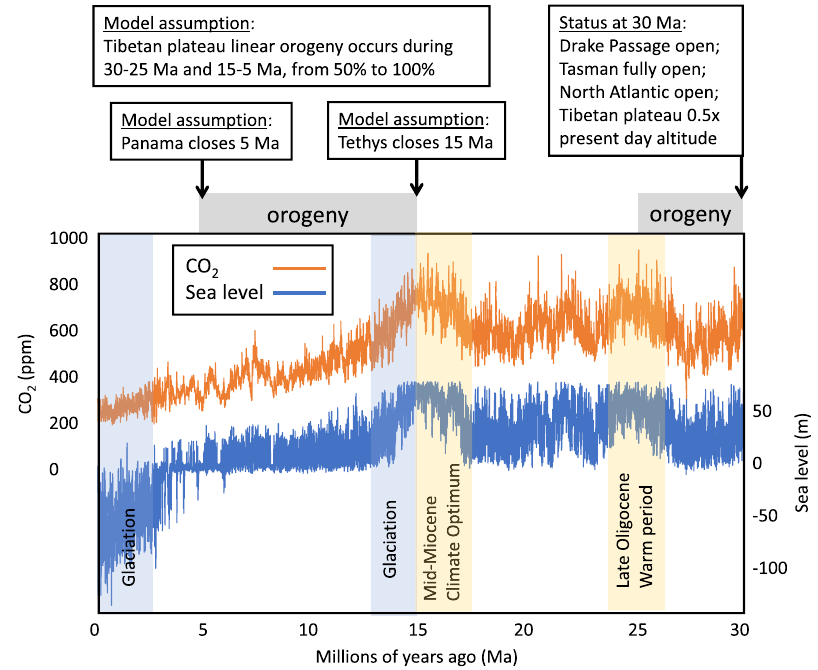
Fig. 1 Major tectonic and climatic boundary conditions considered in the model for the past 30 Myr. Changing boundary condition modelled are Himalayan-Tibetan Plateau (HTP) orogeny 15,28,34,41 – 44 (represented by a globally uniform scaling of orogeny), Tethys gateway closure 27 , Panama gateway closure 61 – 64 , orbital parameters 56 , atmospheric CO 2 47,48 and the ice-sheet state derived from sea-level reconstructions 48 . Model assumptions include linear orogeny lifting between 30 – 25 Ma and 15 – 5 Ma from 50 to 100% of present day, fi nal Tethys closure at 15 Ma and Panama closure at 5 Ma. The model assumes that Drake passage, Tasman and North Atlantic gateways were open at 30 Ma. See Supplementary Materials for discussion of data